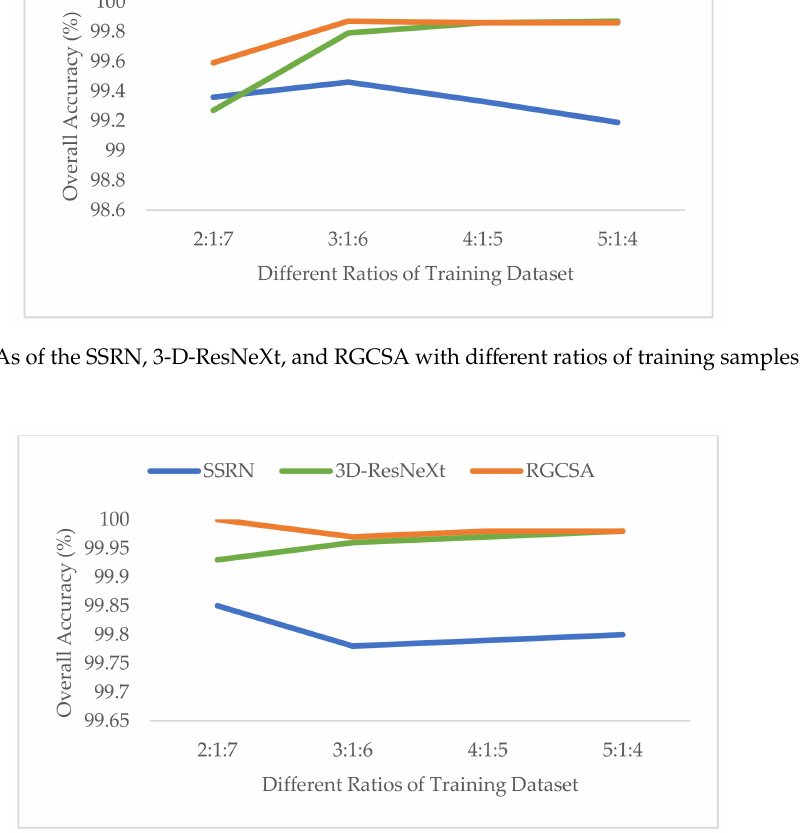
Figure 15. OAs of the SSRN, 3-D-ResNeXt, and RGCSA with di ff erent ratios of training samples for the UP